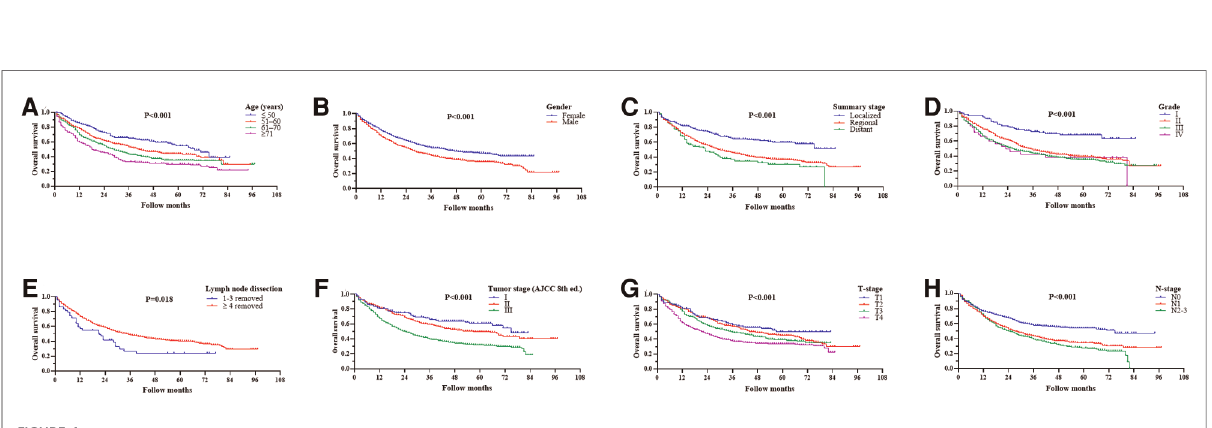
FIGURE 4 Ording to age ( A ), gender ( B ), summary stage ( C ), grade ( D ), lymph node dissection ( E ), tumor stage ( F ), T-stage ( G ), and N-stage ( H